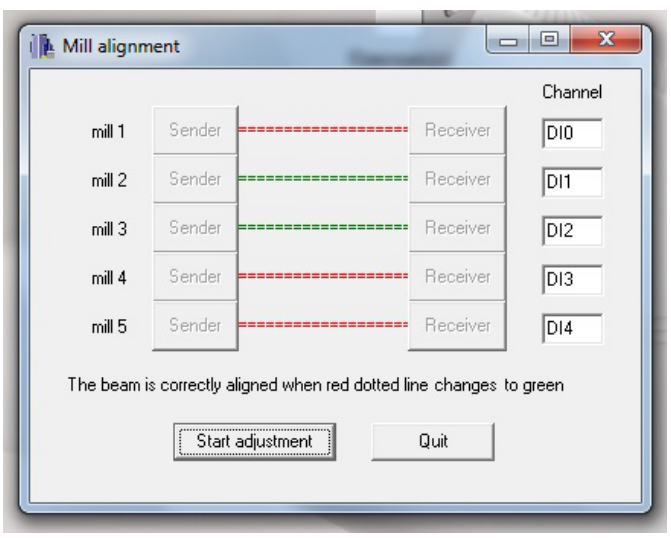
Figure 12. Interface of application for infrared beam